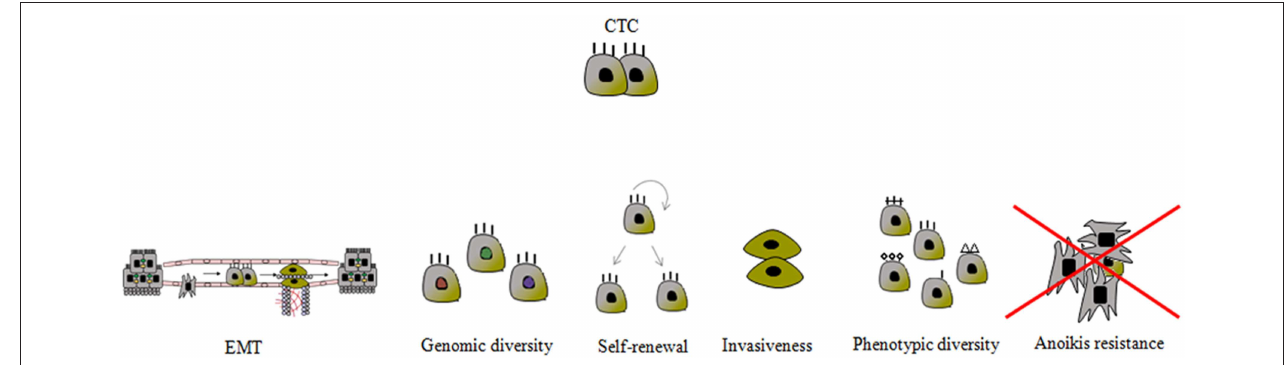
FIGURE 3 | Schematic presentation of the most important CTC characteristics. The mechanisms to prevent anoikis are still unknown. CTC phenotypic diversity refers not only to the epithelial-mesenchymal transition (EMT) phenomenon, but also to the expression of proteins associated with apoptosis, proliferation, invasion and chemotaxis, and it is closely related to genotypic